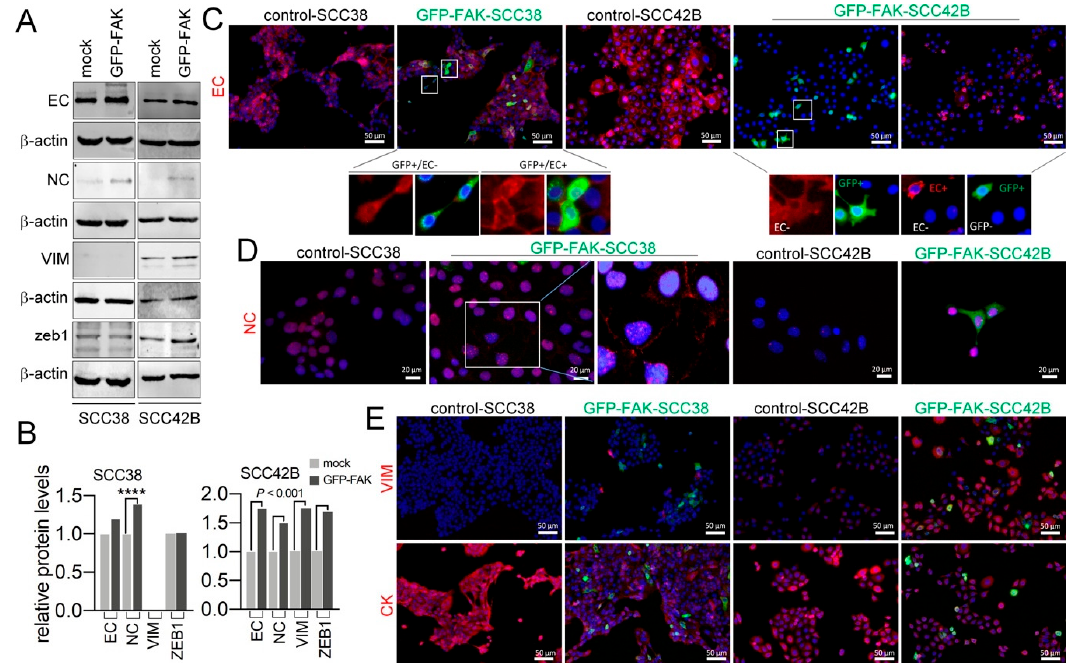
Figure 7. FAK over-expression in SCC cells favors epithelial to mesenchymal transition (EMT) of adjacent non-transduced SCC cells. ( A ) Representative immunoblot of E-cadherin (EC), N-cadherin (NC), vimentin (VIM) and ZEB1 in mock- or GFP-FAK transfected SCC cells. The membranes were stripped and reprobed with anti- β -actin antibody to assure even loading of proteins in each lane. The ratio EC, NC, VIM or ZEB1/ β -actin was estimated by densitometry. Quantification of the relative protein levels is shown in ( B ). ( C – E ) Representative images of immunostaining for EC, NC, VIM and CK in the indicated cells. Insets in C are shown to highlight that GFP-positive cells at the periphery, but not in the middle, of the migrating nests lose EC immunostaining. The inset shown in panel ( D ) is an over-exposed image to highlight the membrane NC immunostaining in GFP-FAK-SCC38 cells. **** p < 0.0001.